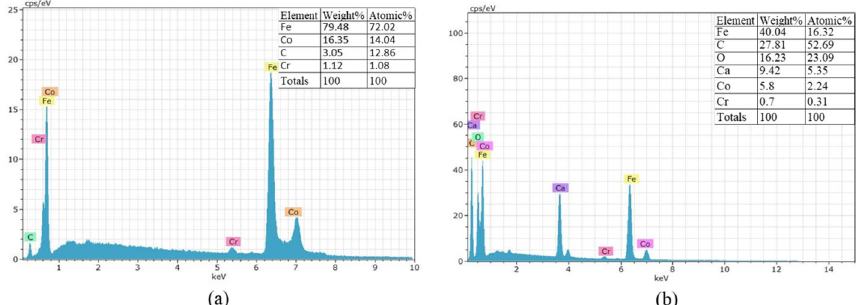
Fig. 11 Energy dispersive (EDX) of worn-out balls for sample a J00 and b